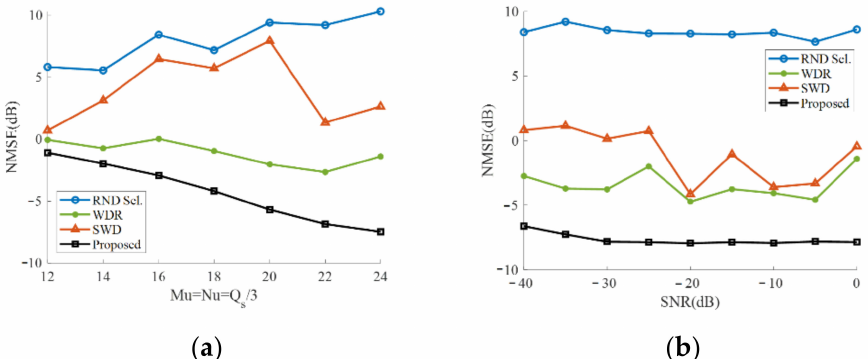
Figure 13. ( a ) NMSEs of different imaging methods against the numbers of selected antennas/sub- pulses and ( b ) NMSEs of different imaging methods against SNRs. The imaging methods are random selection (RND Sel.), WBI detection and removal (WDR), simple waveform design (SWD), and the proposed